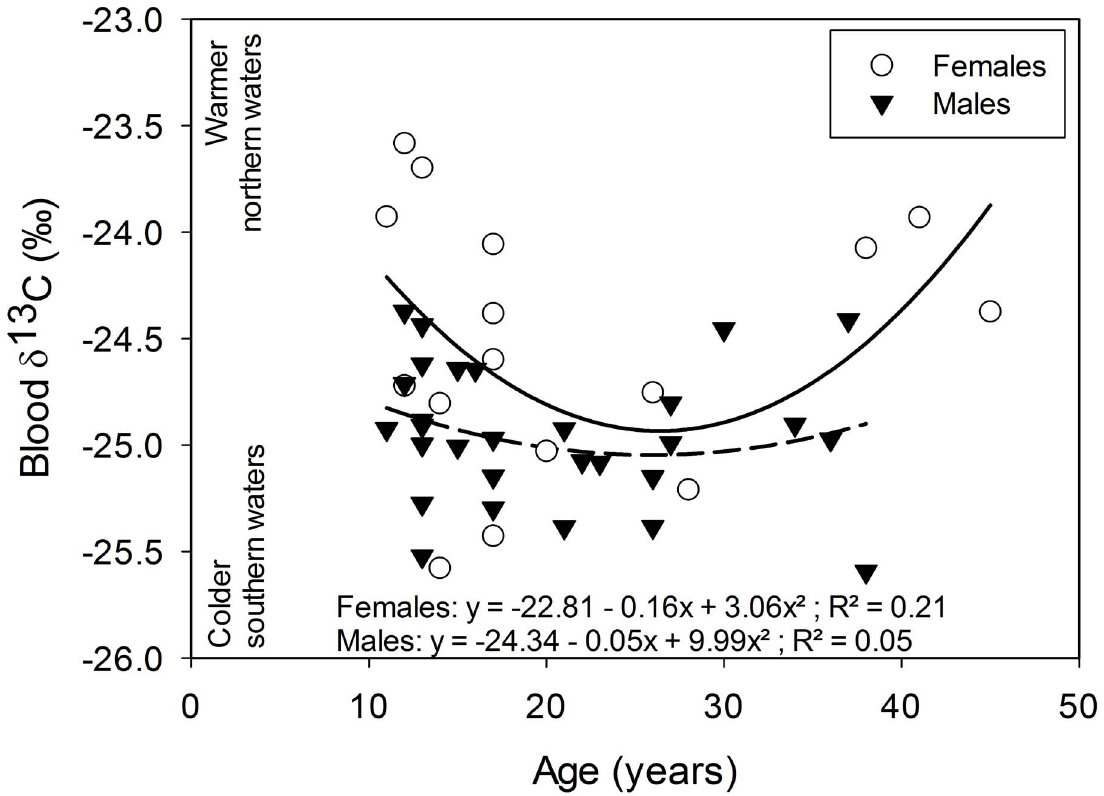
Figure 2. Blood d 13 C values in relation to age in pre-laying snow petrels. d 13 C values quadratically varied with age and this was more pronounced in females (white circles) than in males (black triangles). Solid line refers to quadratic regression for females and dashed line to quadratic regression for males.